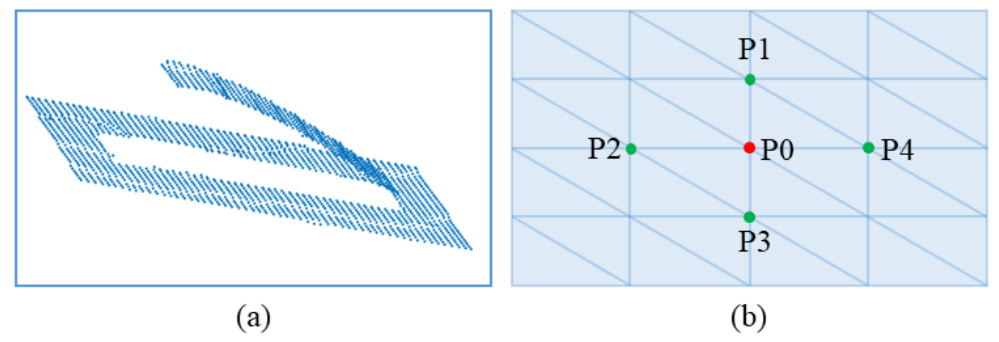
Figure 4. Demonstrate 5 points representation. ( a ) Point cloud model of the workpiece, ( b ) A set of five extracted